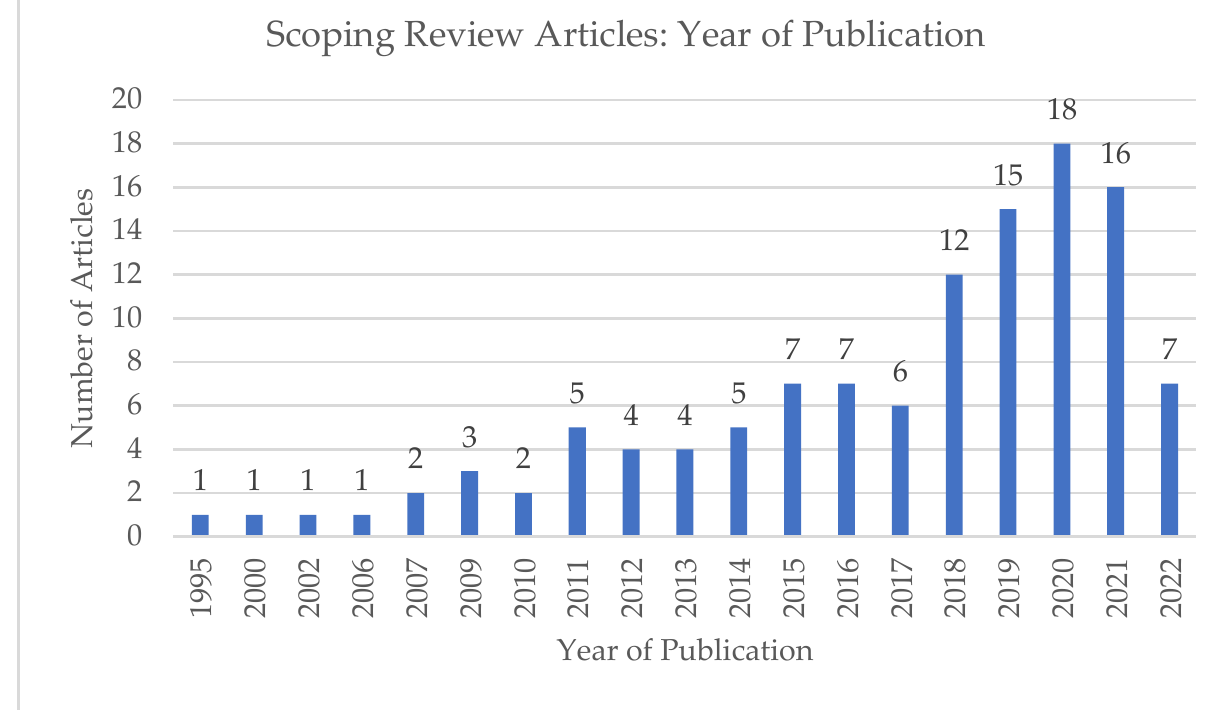
Figure 1. Year of publication of scoping review articles .